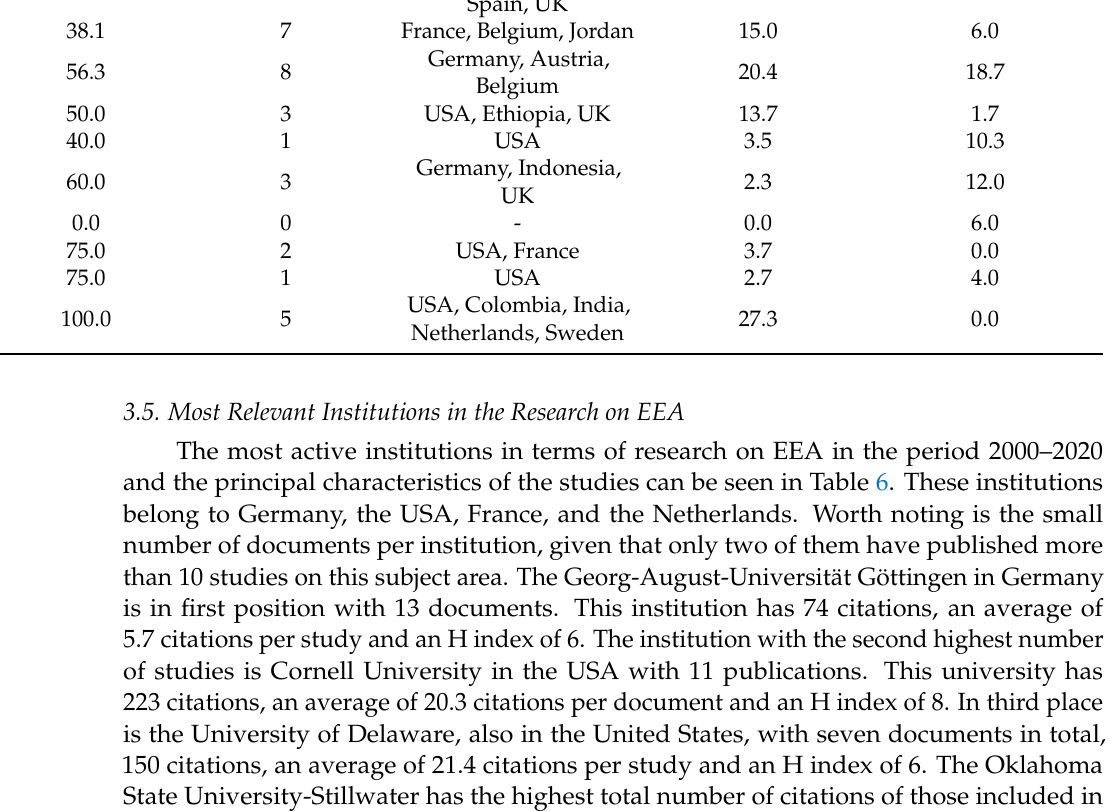
Table 5. Major characteristics in the collaboration of the most active countries related to EEA research. Percentage of Number of Main Collaborators Country Collaboration Collaborators